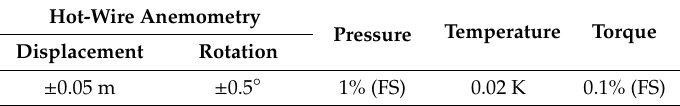
Table 3. Error of the measurements.